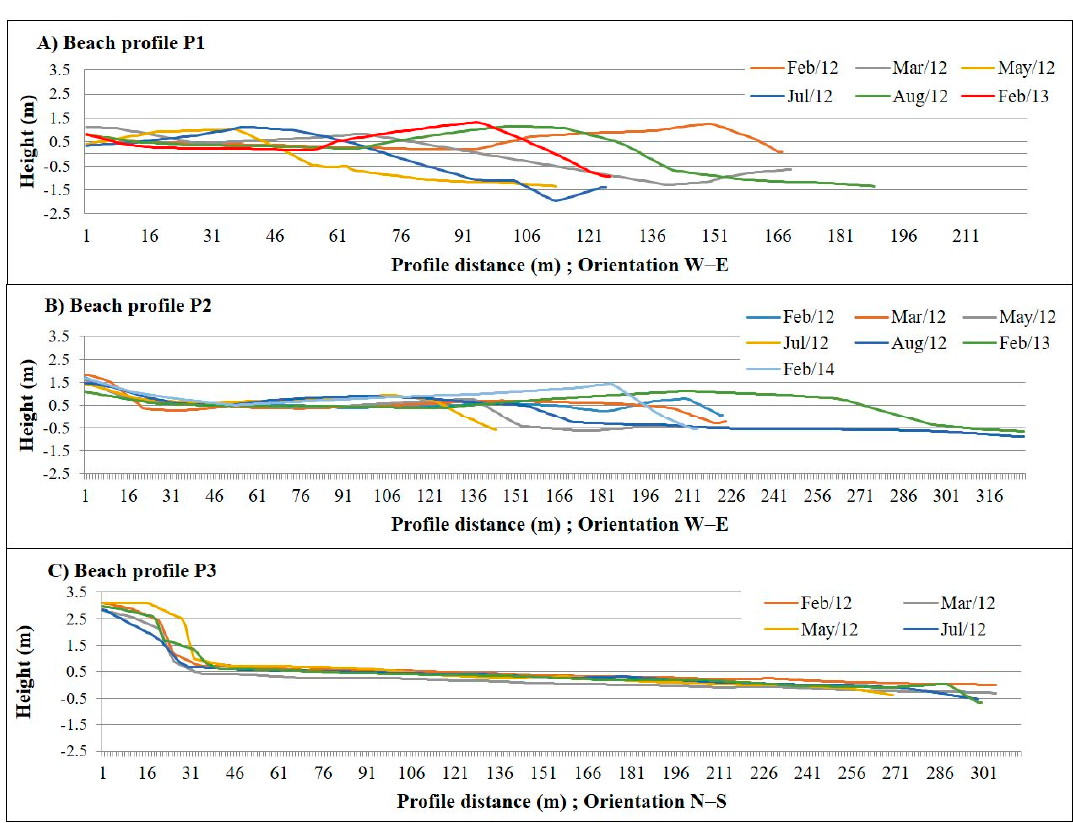
Figure 8. Beach profiles, Tubul Bay. The beach profiles were surveyed in postearthquake conditions on a seasonal basis (winter-summer). They present wide variability ( A , B ), with the exception of profile 3 ( C ), which is located in a more protected area of the bay. See Figure 2A for the location of each profile.